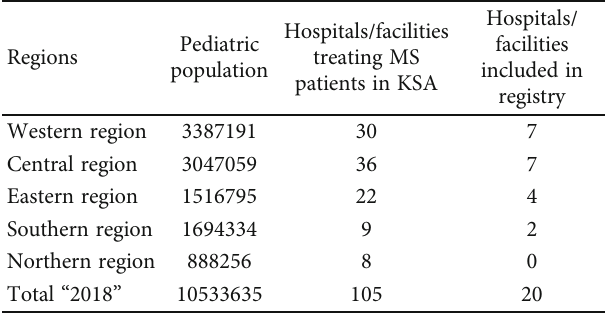
∗ Table adapted from AlJumah, M., Bunyan, and R., Al Otaibi, H. et al. Table 2. The prevalence of pediatric onset MS varied between the di ff erent regions in the Kingdom and was found to be the highest for the western region. Projected prevalence with respect to regions was found to be di ff erent, with the highest prevalence reported in the eastern region followed by the western, northern, central, and southern.